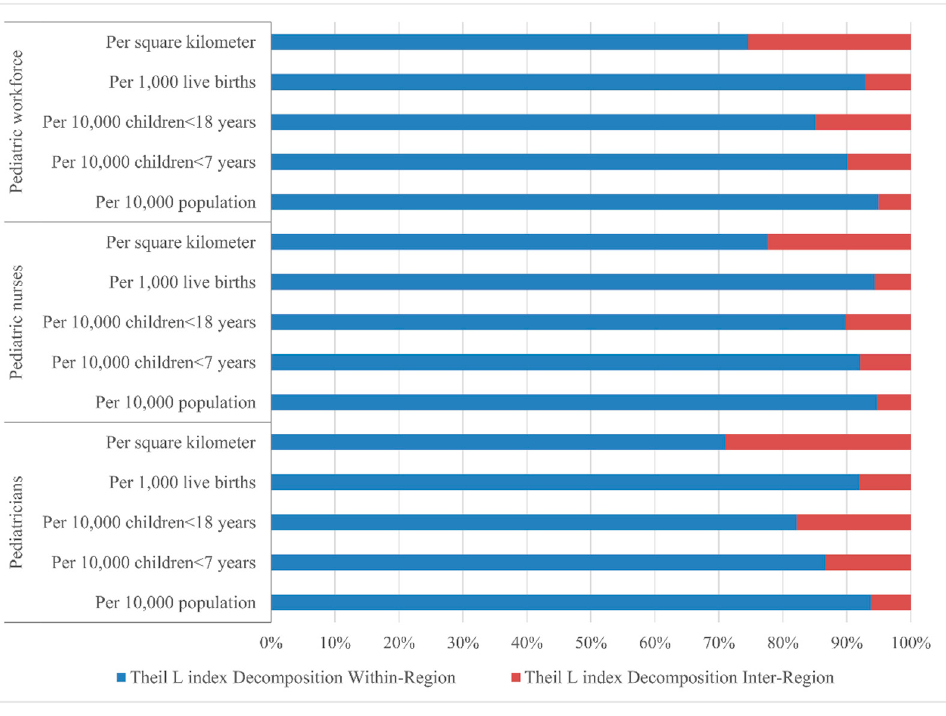
Figure 5. The share of inequality sources by Theil decomposition.